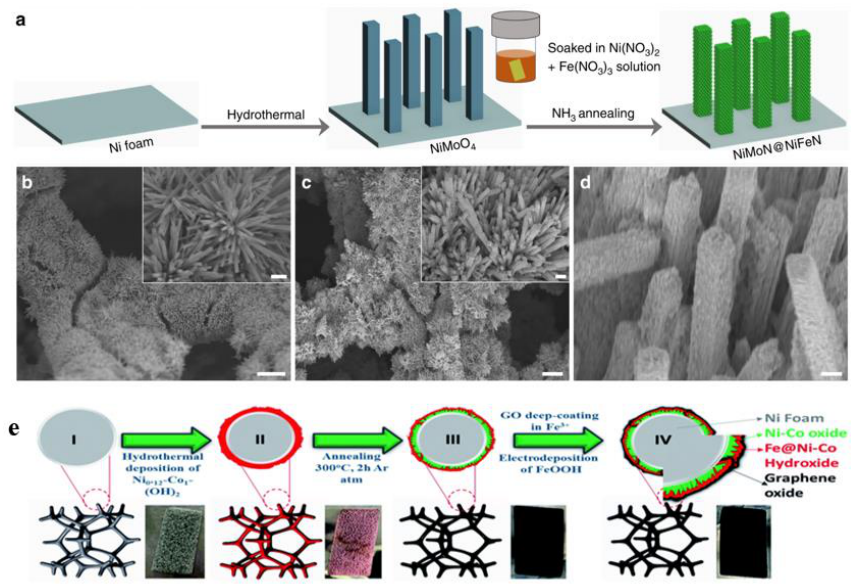
Figure 7. ( a ) Schematic image of the synthesis procedure for the NiMoN@NiFeN catalyst [66]. SEM images of ( b ) NiMoN and ( c , d ) NiMoN@NiFeN with scale bars of 30 μm, insets 3 μm [66]. ( e ) Schematic illustration of the preparation process [67]. Adapted with permission from Ref. [66], Copyright 2019, Springer Nature. Ref. [67], Copyright 2020, Royal Society of Chemistry.